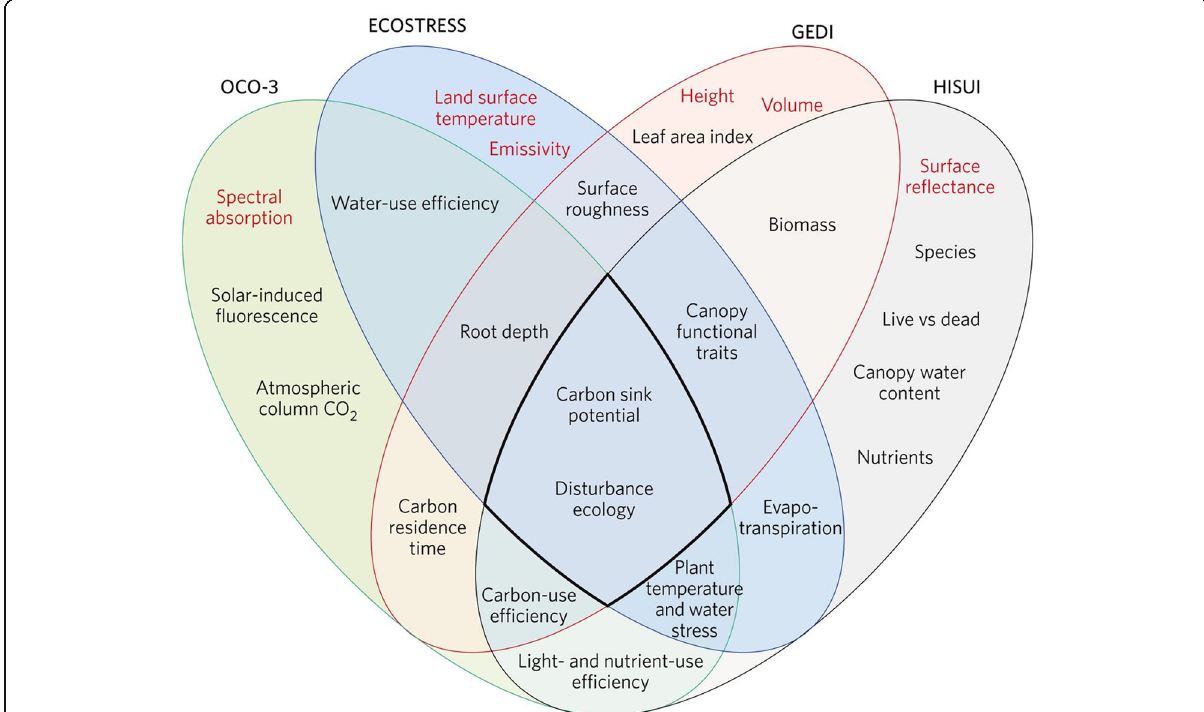
Fig. 18 The capabilities of four hosted ISS instruments for Earth observations during 2019 – 2023 are shown. The measurement types of each are listed within ellipses: OCO-3 (green), ECOSTRESS (blue), GEDI (pink), and HISUI (grey). The overlaps are where multiple instruments will provide measurements of related variables. Additionally, the central region outlined in black is where all four instruments contribute measurements related to change detection and disturbance and the potential for supporting carbon sink quantification. Figure reproduced with permission from Stavros et al.